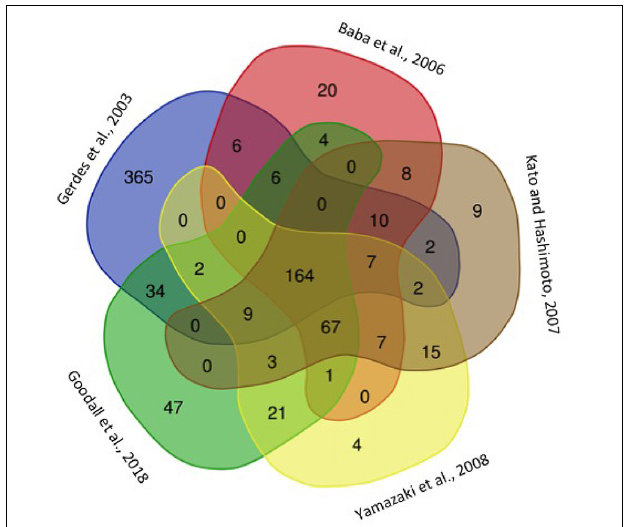
FIGURE 1 | Venn diagram showing the Escherichia coli predicted essential genes in different studies. The name of the first author of each study where essential genes are predicted is shown. The total number of genes predicted in these studies is presented in Supplementary Table